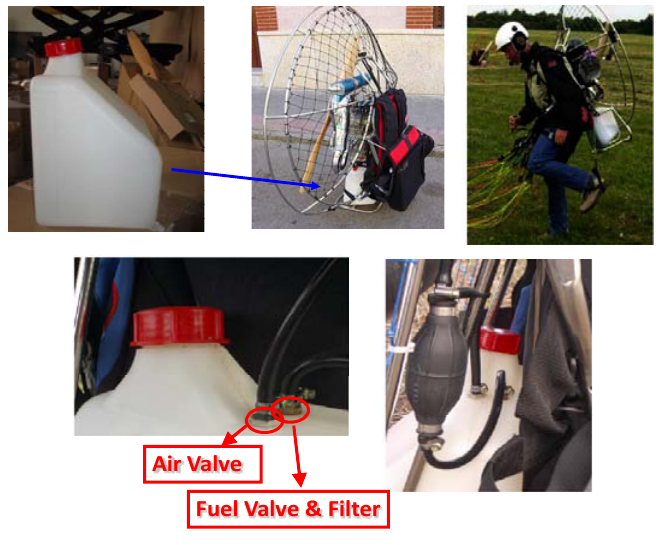
Figure 1. Real application